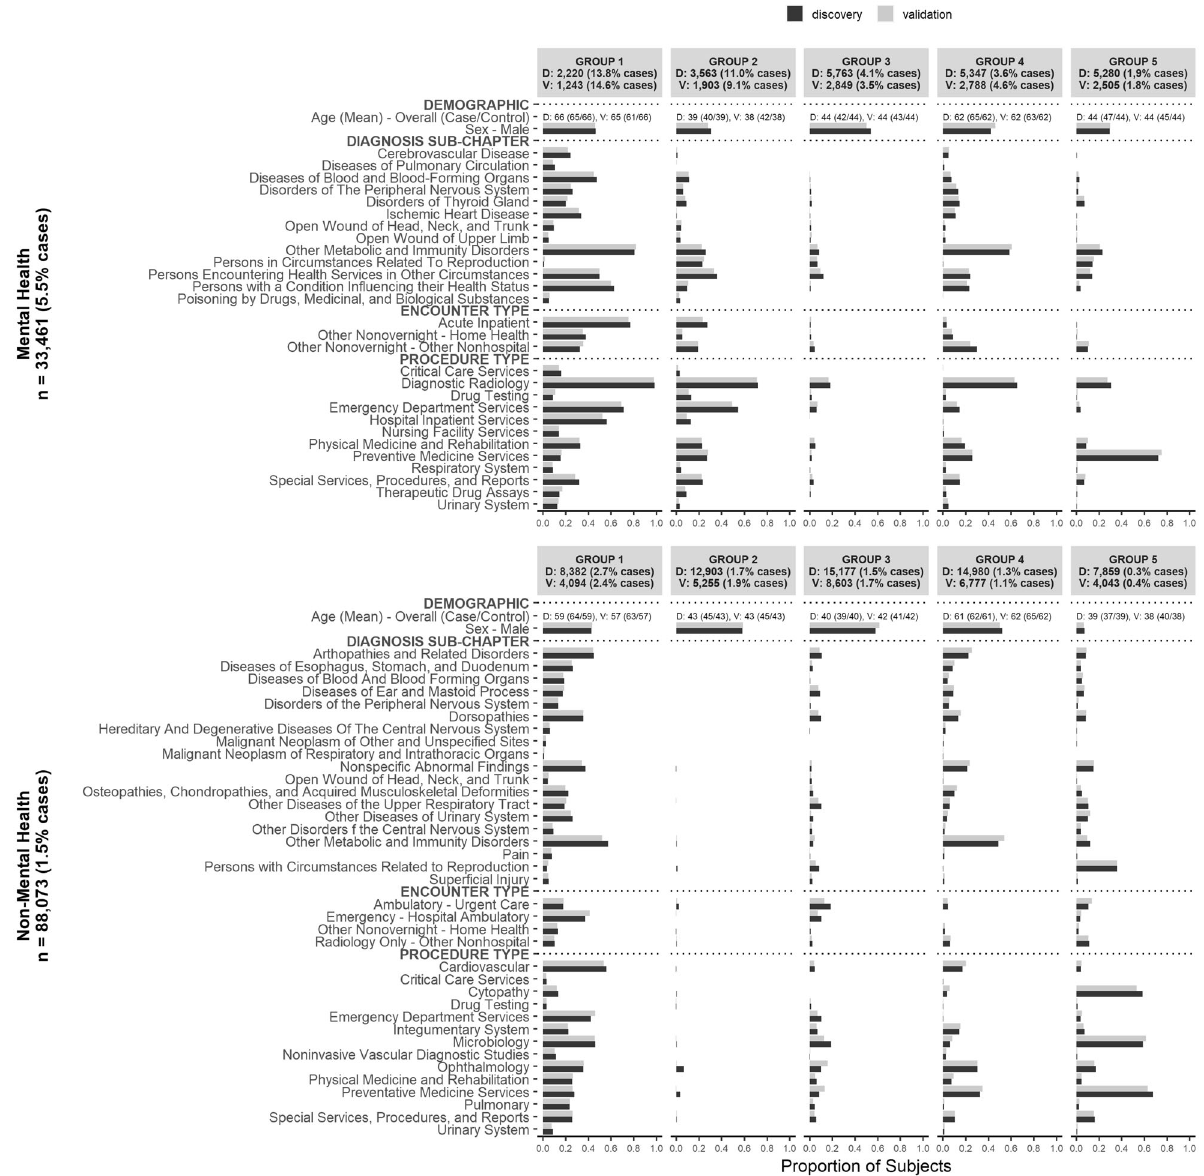
Fig. 2 Latent class analysis sub-group identi fi cation based on health care indicators associated with suicide death in individuals A) with and B) without a mental health diagnosis. For each mental health stratum, latent class analysis (LCA) was performed based on health care indicators identi fi ed in the respective penalized regression models in the discovery sample. LCA was performed in the discovery sample (D), followed by con fi rmatory LCA in the validation sample (V). The frequency of cases is displayed overall and for each LCA sub-group for both D and V samples. Within each stratum, the LCA sub-group-speci fi c frequency are displayed for those health care indicators where at least 9 of the 10 ratios of the pairwise group frequencies were >1.5 (ie. sub-group distinguishing